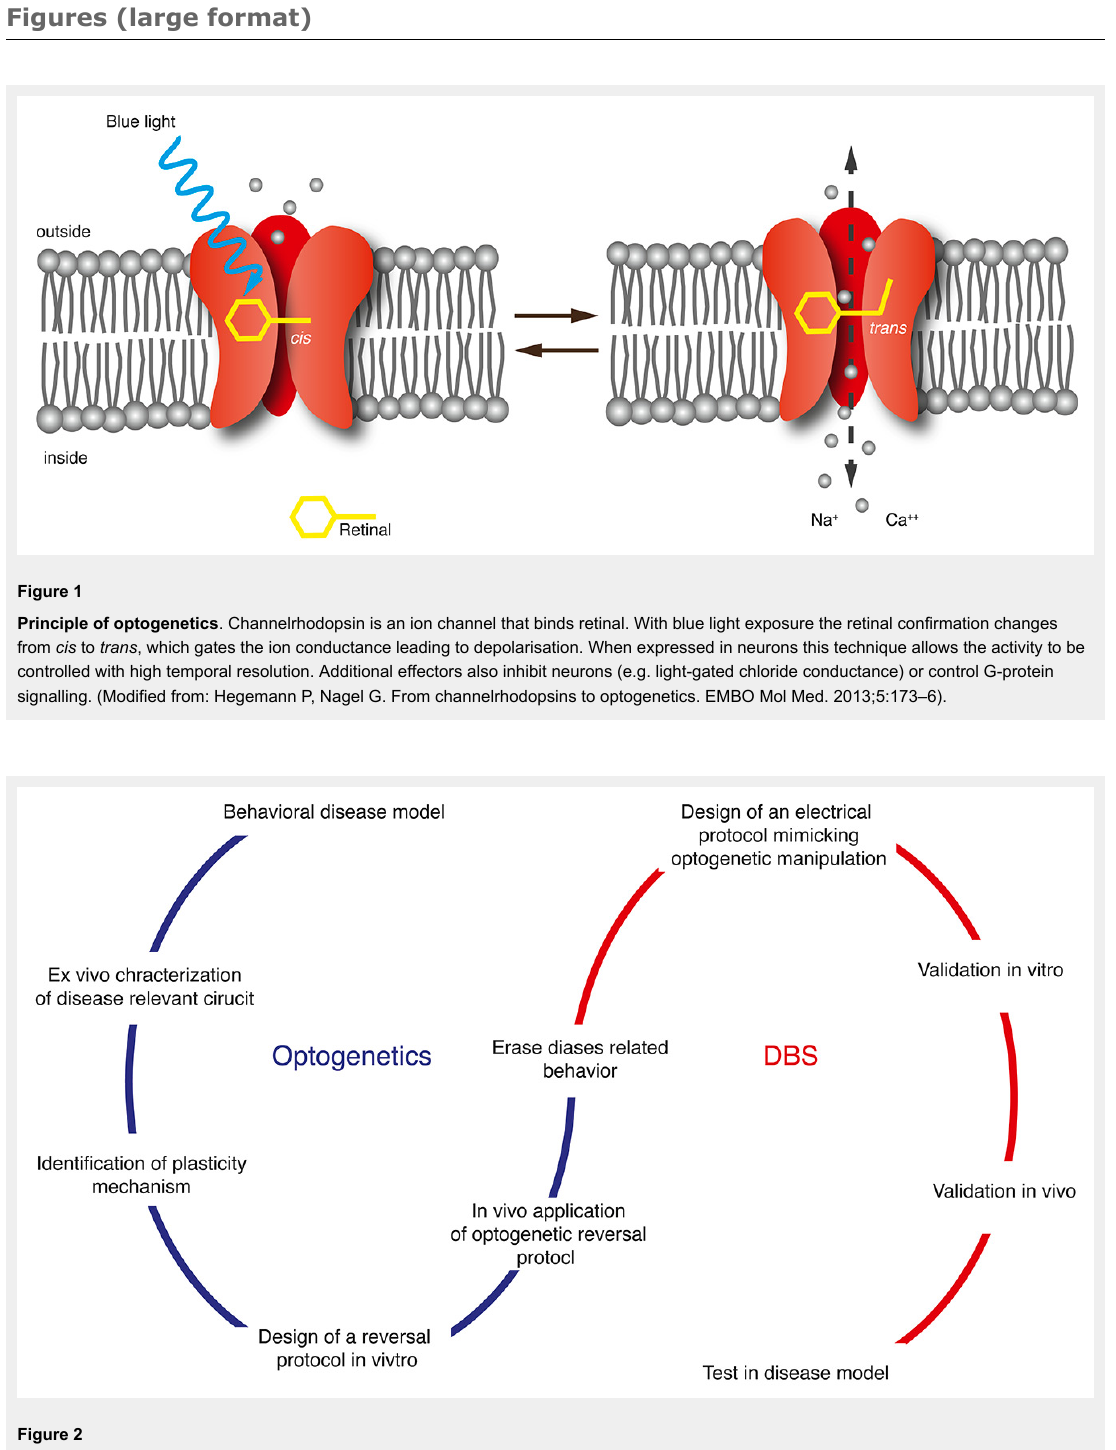
Blueprint of translation of optogenetic approaches into novel protocols of deep brain stimulation (DBS) . Research starts in animal models of the disease and with identification of the relevant circuits. A crucial step is the in vitro emulation of the successful optogenetic protocol with DBS, still in animal models. Once validated in vivo , protocols can be designed for human